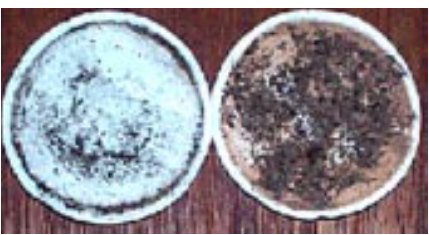
Figura 1. Detalhe da fração leve intra-agregado (esquerda) e da fração leve